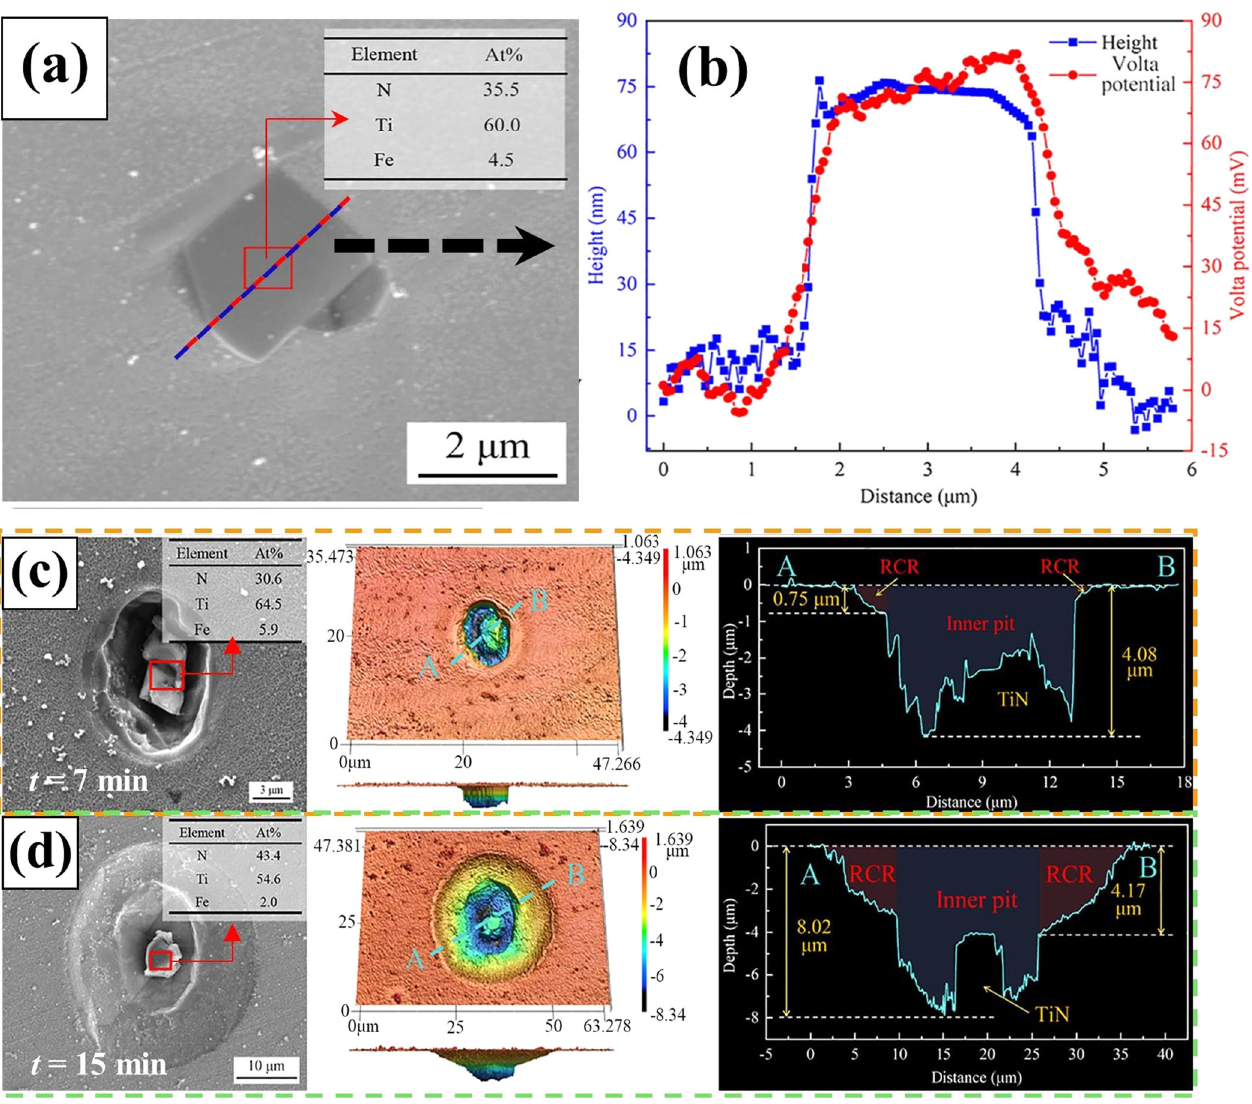
Fig. 9 Typical morphology, properties and corrosion performance of TiN inclusions in interstitial free steel. a SEM images of TiN inclusions in interstitial free steel. b Morphology and potential results of line pro fi le in the same region from a . c , d Ex-situ SEM morphological observation of corrosion pit induced by TiN inclusions with time in 0.1 M NaCl solution after removal of corrosion product: c 7 min and d 15 min. Corresponding three-dimensional images and cross-section of the corrosion pit are illustrated on the right 87